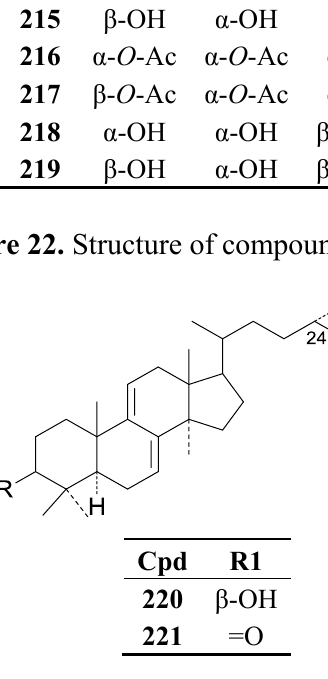
Table 9. Ganoderma triterpenes ( 222 – 260 ) in Figure